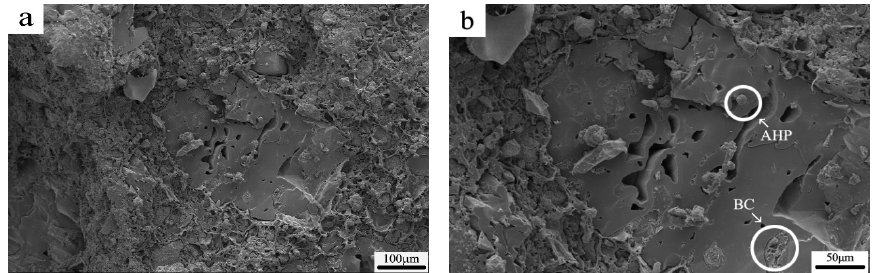
Figure 9. SEM images of fractured surface of BC/PLA/AHP (25/50/25) composites before combustion: ( a ) 100 μ m; ( b ) 50 μ m.